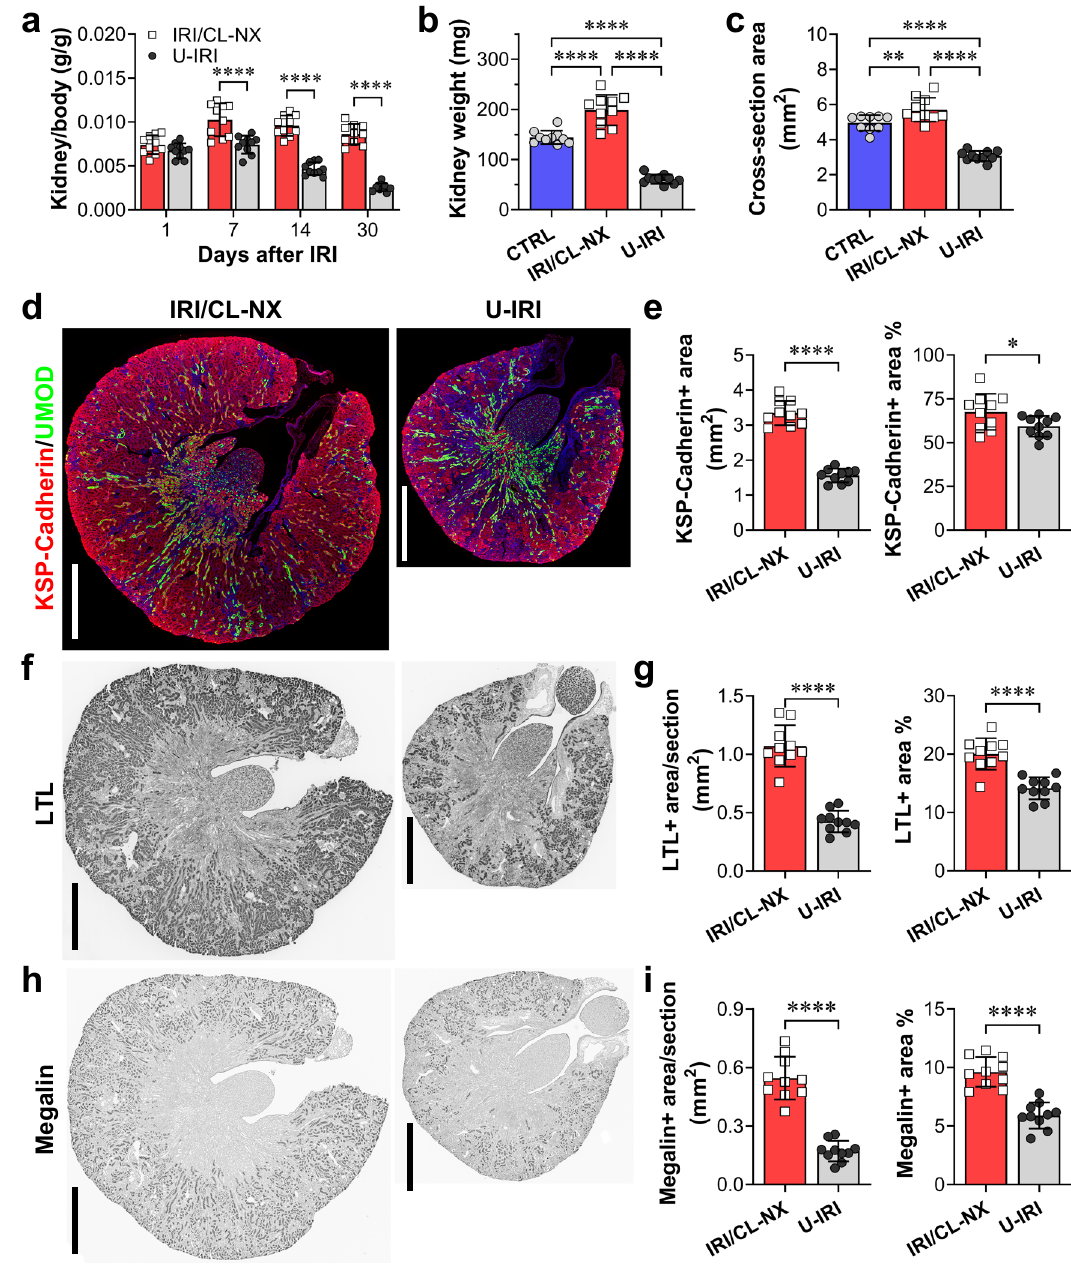
Fig. 1 | U-IRIleads to tubule atrophy. Wild-typemice were subjected to 27min of ischemia/reperfusion injury (IRI) with contralateral nephrectomy (IRI/CL-NX) or unilateral IRI (U-IRI) and sacri fi ced on day 1, 7, 14, and 30 after injury. a Kidney-to- body weight ratios were determined on day 1, 7, 14, and 30 after injury. Data are presentedasmean±SD. n =10kidneys/timepoint. p <0.0001betweenmodelsand in time series (by two-way ANOVA); **** p <0.0001 in the indicated subgroup ana- lyses (by Bonferroni multiple comparison). b Kidney weights were determined on day 30 after injury. CTRL, age-matched control. Data are presented as mean±SD. n =9 control kidneys. n =10 kidneys/model. p <0.0001 by one-way ANOVA; **** p <0.0001 inthe indicated subgroup analyses (by Tukeymultiple comparison). c Midline kidney cross-section area was determined on day 30 after injury. CTRL, age-matchedcontrol.Dataarepresentedasmean±SD.n=9controlkidneys. n =10 injured kidneys/model. p <0.0001 by one-way ANOVA; ** p <0.01 ( p =0.0075), **** p <0.0001 inthe indicated subgroup analyses (by Tukeymultiple comparison). d Midline kidney sections on day 30 after IRI were co-stained with kidney-speci fi c